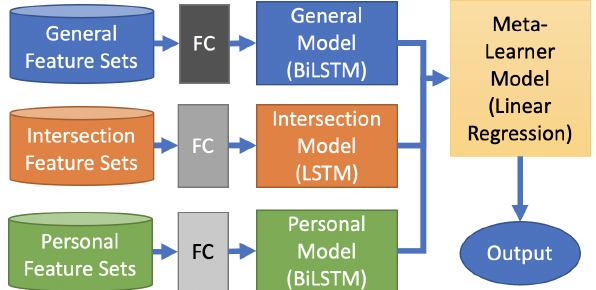
Figure 4. The data-driven stacking-based Model: an